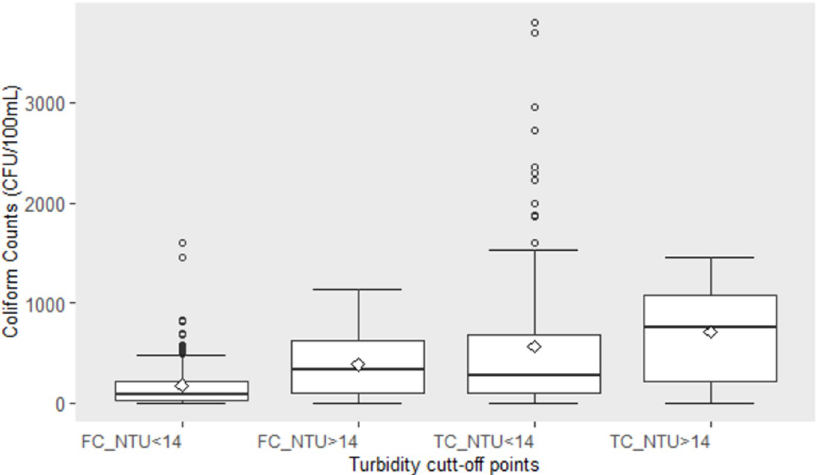
Fig 4. Boxplots of Mean coliform counts (CFU/100mL) determined by citizen scientists based on turbidity measurements, above and below 14 NTU cutoff points. FC_NTU < 14 = Mean fecal coliform counts below 14 NTU, FC_NTU < 14 = Mean fecal coliform counts above 14 NTU, TC_NTU < 14 = Mean total coliform counts below 14 NTU and TC_NTU > 14 = Mean total coliform counts above 14 NTU. Bars represent standard deviation and points represent variation around mean.